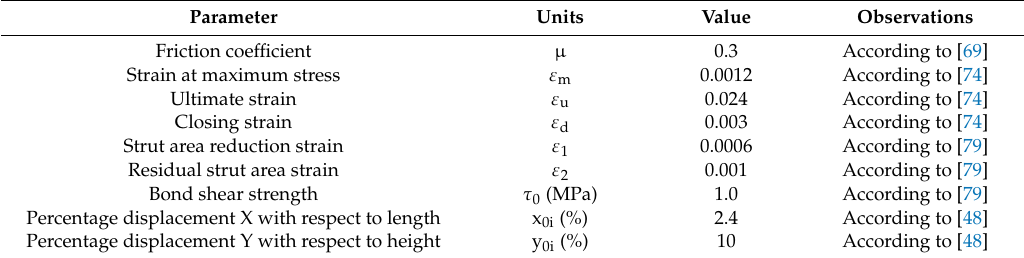
Table 8. Geometric and mechanic parameters assumed from literature